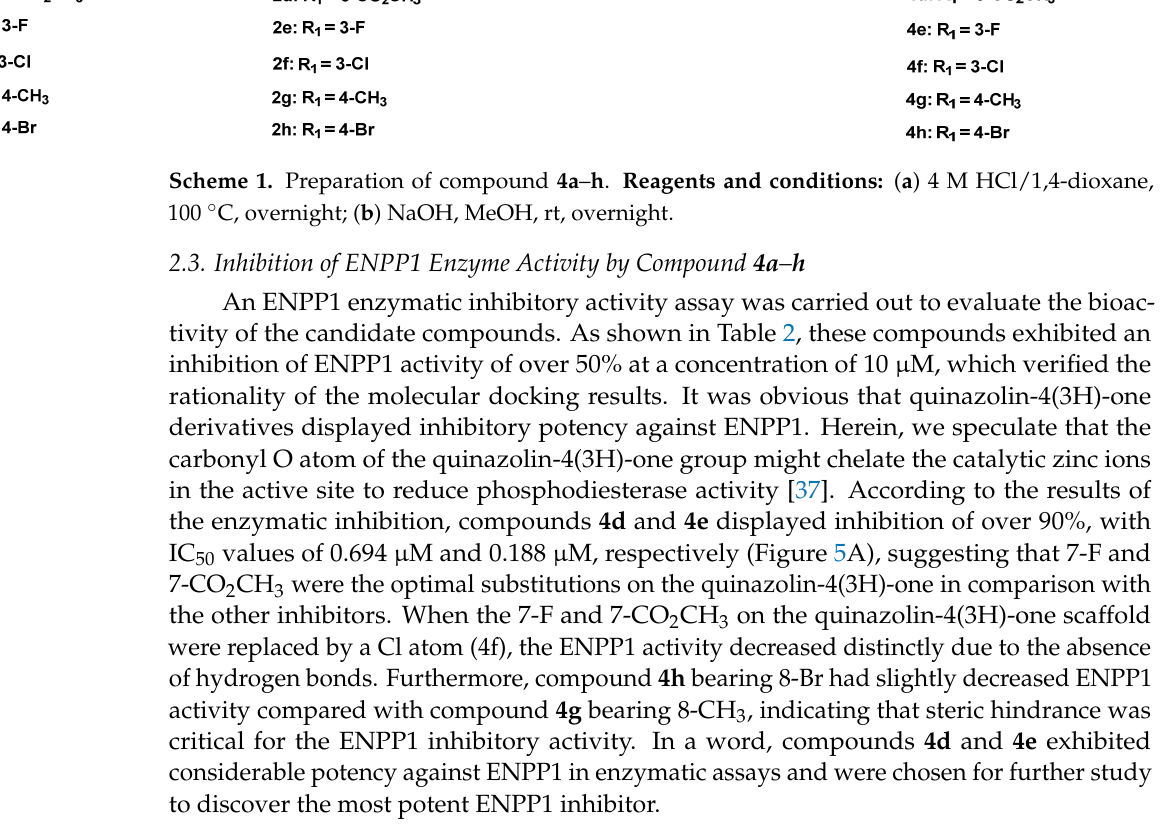
Table 2. Enzymatic inhibition of ENPP1 at 10 µ M 4a – h .